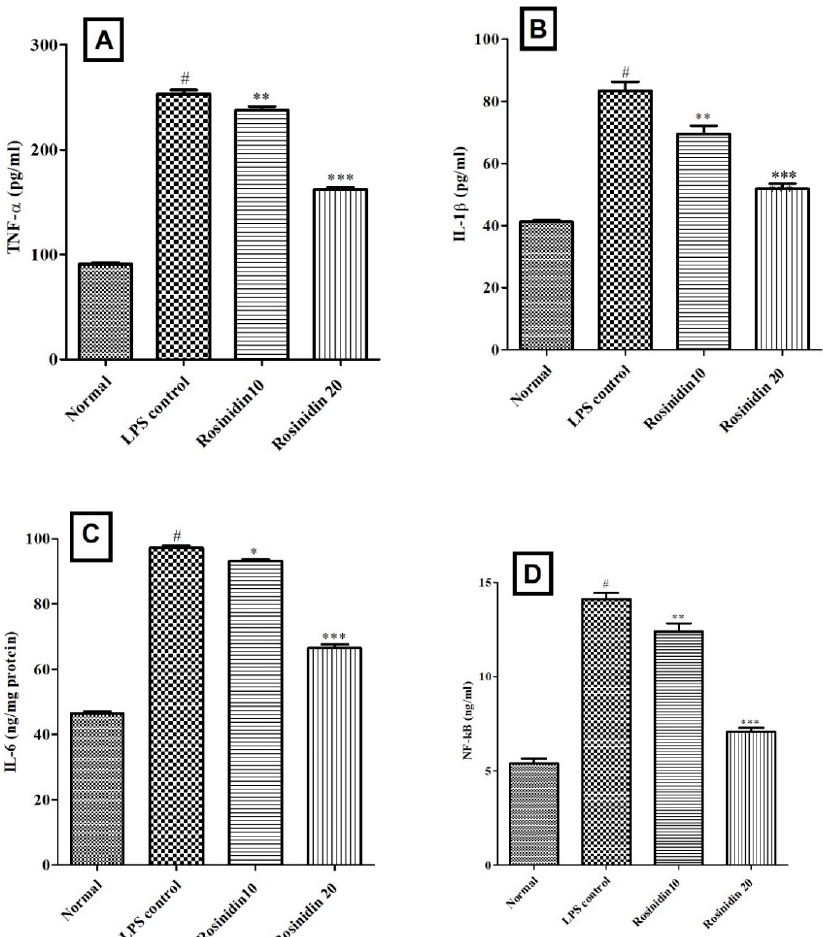
Figure 10. Effect of rosinidin on endogenous antioxidant status in LPS-treated rats. ( A ) tumour necrosis factor (TNF- α ), ( B ) interleukin-1 β (IL-1 β ), ( C ) interleukin-6 (IL-6) and ( D ) nuclear factor κ B (NF κ B). Values are expressed in mean ± S.E.M. (n = 6). # p < 0.05 vs. normal control rats and * p < 0.05, ** p < 0.01, and *** p < 0.001 vs. LPS control rats. One-way ANOVA followed by Tukey’s post hoc test. 3.5. BDNF